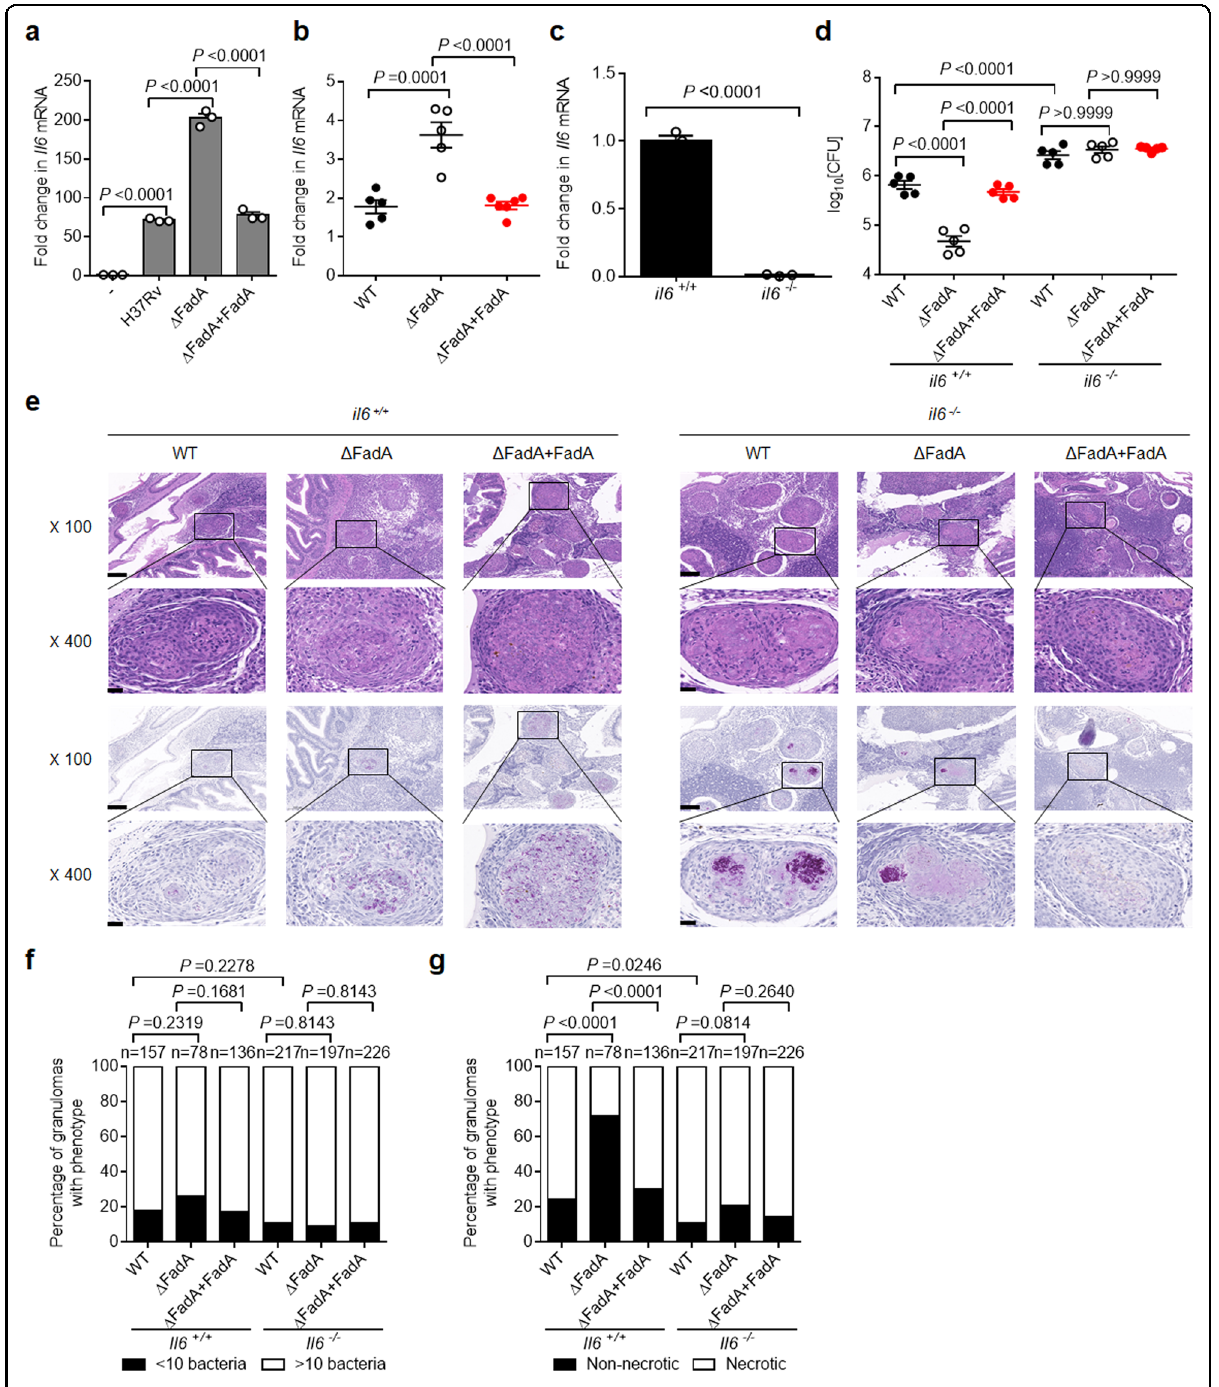
Fig. 3 (See legend on next